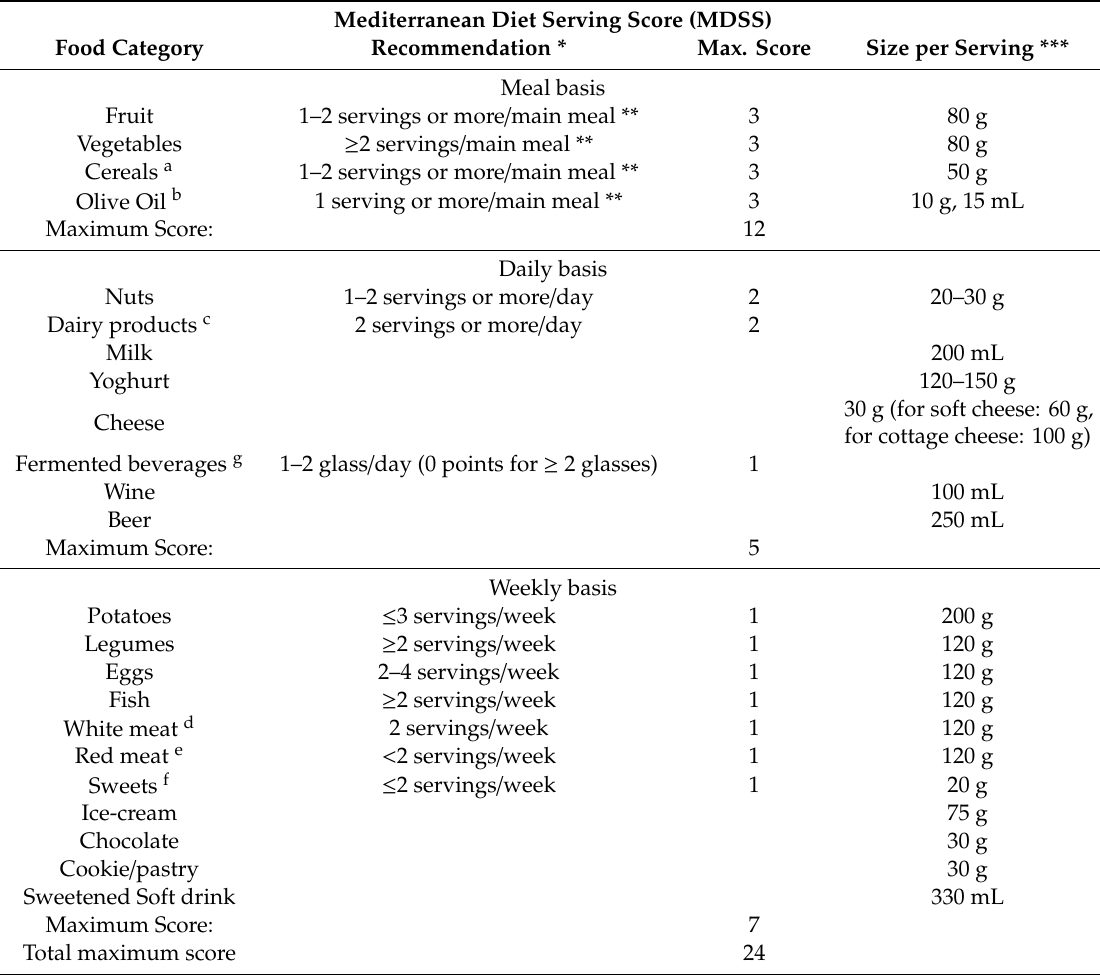
Table 1. Mediterranean diet (MD) Serving